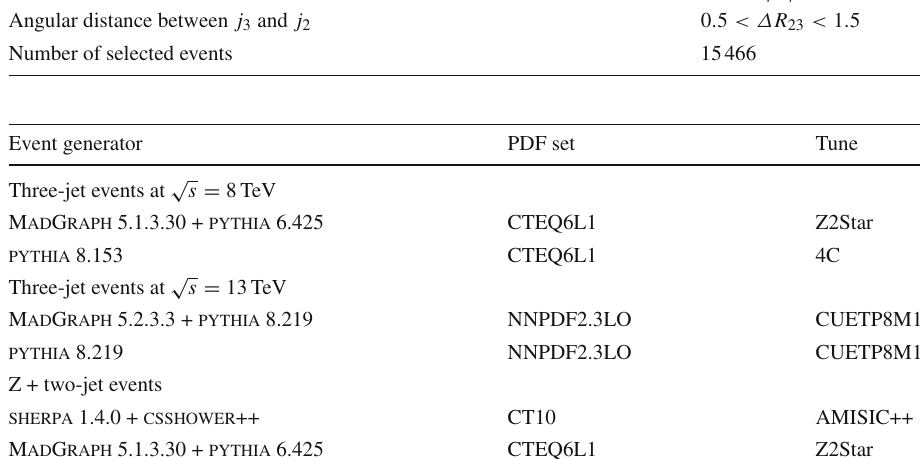
Table 2 Event generator versions, PDF sets, and tunes used to produce MC samples at reconstruction